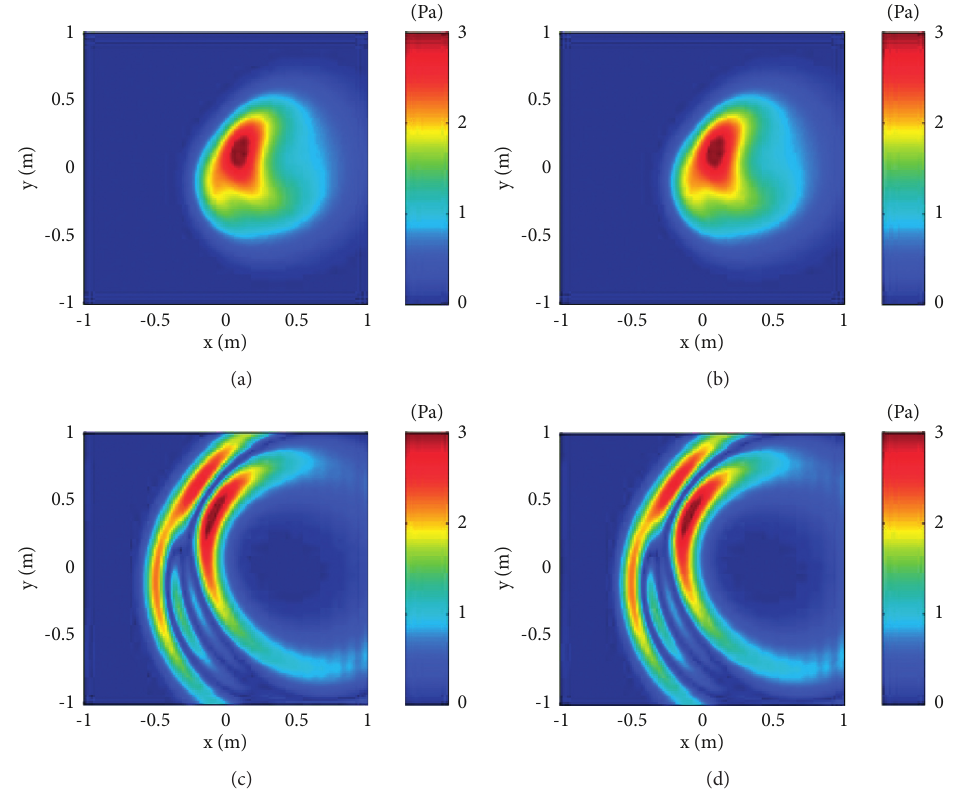
Figure 7: The theoretical and calculated pressures on the prediction plane z (a) and 250 Δ t (c) and the calculated pressures at 150 Δ t (b) and 250 Δ t